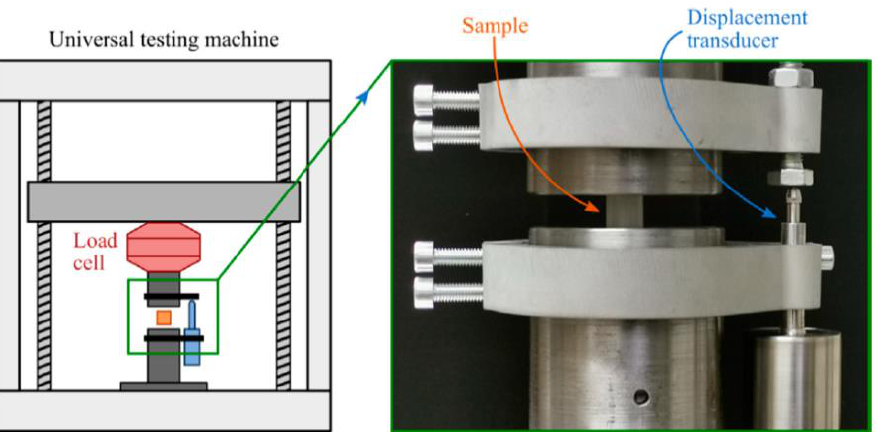
Figure 1. Schematic diagram of the universal testing machine (UTM) ( left ) and the located sample between the compression plates ( right ) [35].